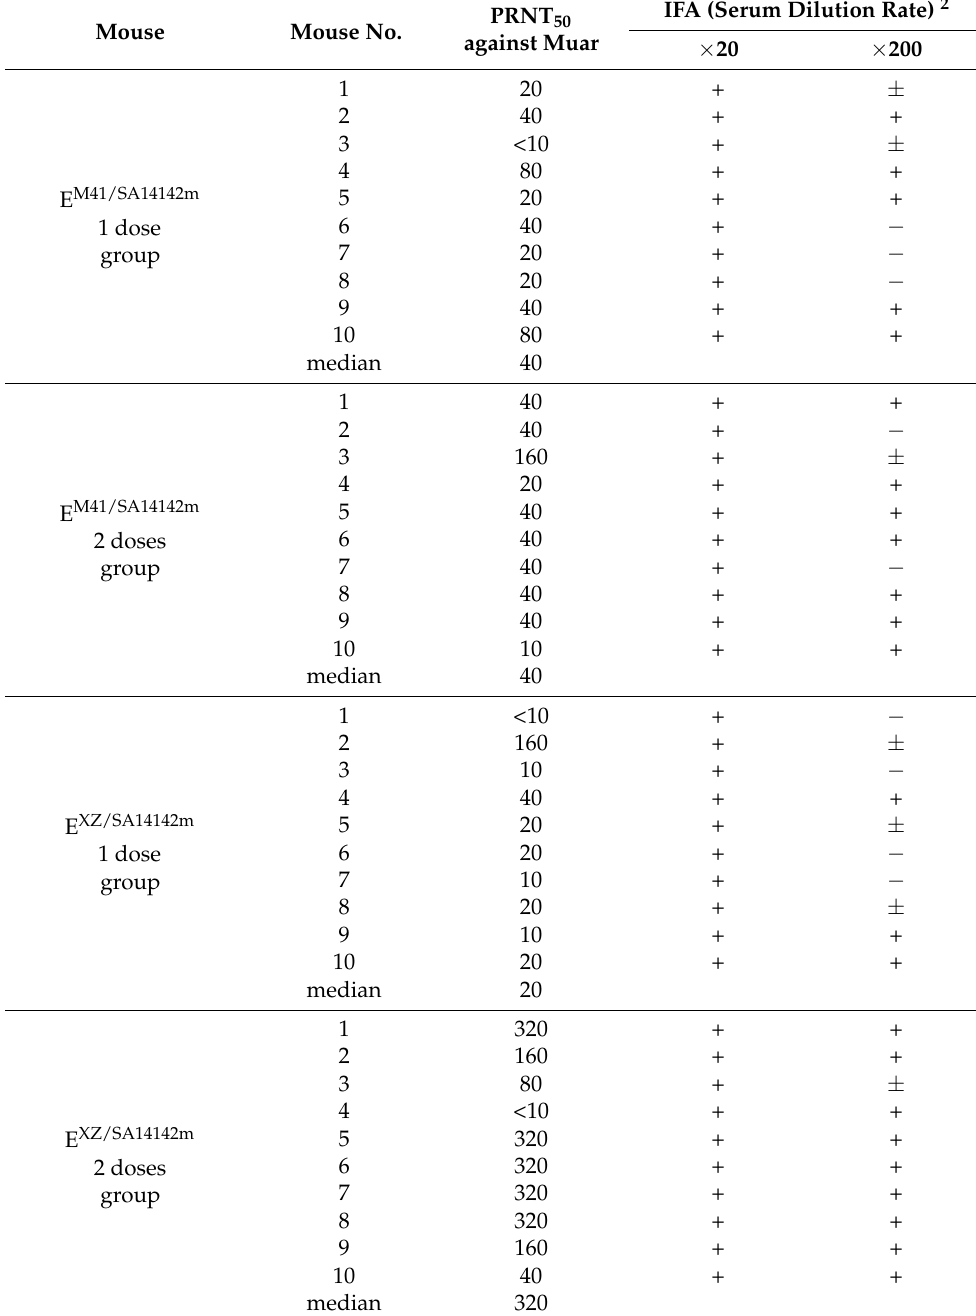
Table 2. Neutralization titers (PRNT 50 ) and results of indirect immunofluorescent analysis (IFA) of sera from mice inoculated with one or two doses of recombinant JEVs 1